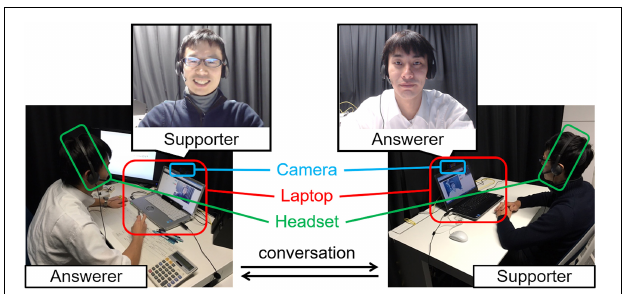
FIGURE 2 | Measurements of the heartbeat, respiration, and perspiration. The heartbeat was obtained from an ECG signal, and the perspiration was evaluated via the skin